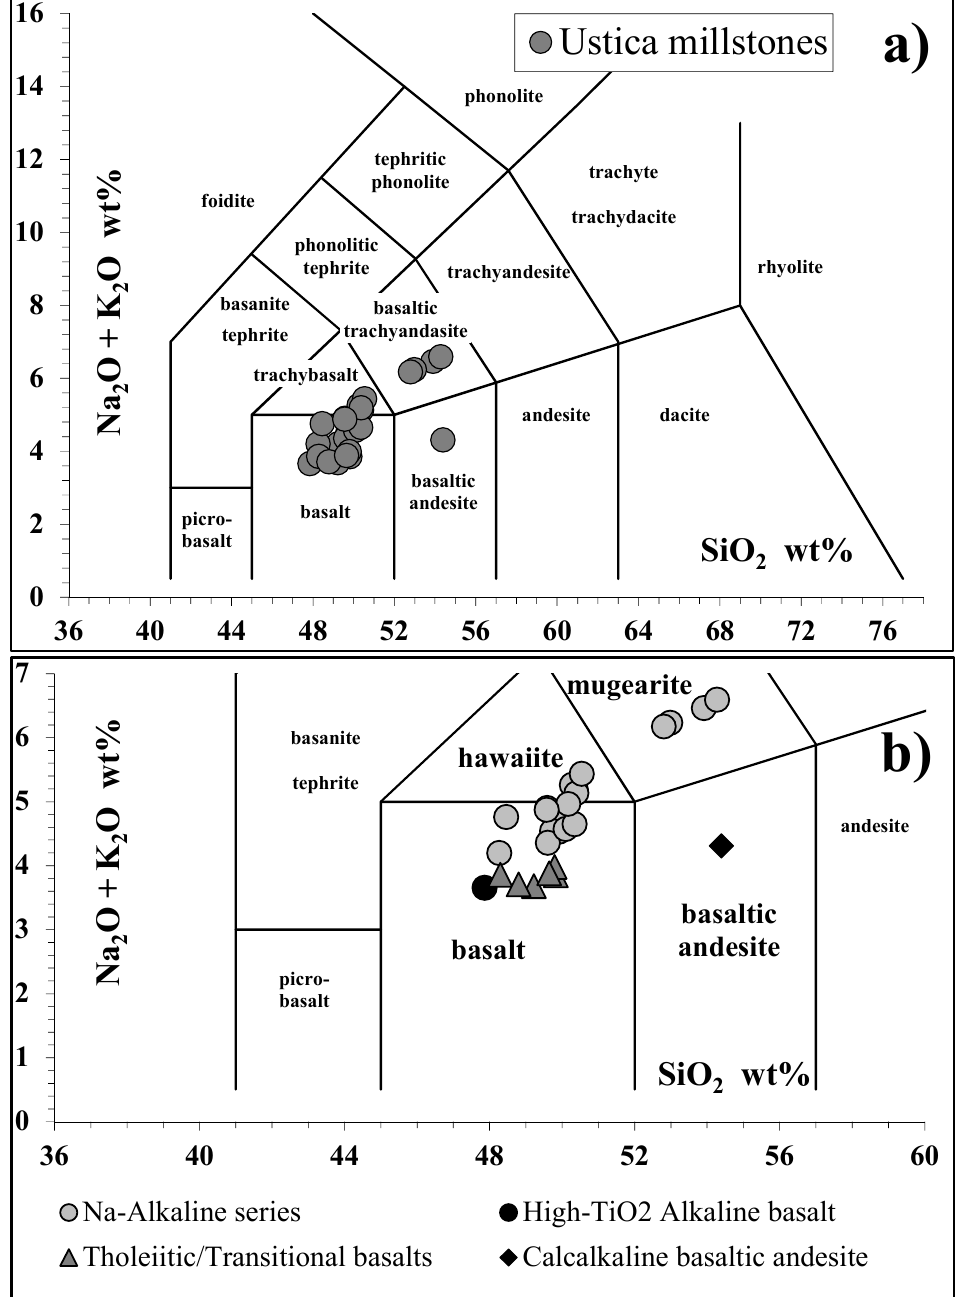
Figure 4. Total Alkali-Silica classification diagram [52]. The investigated millstones are reported as a whole ( a ) and following their magmatic series ( b ).